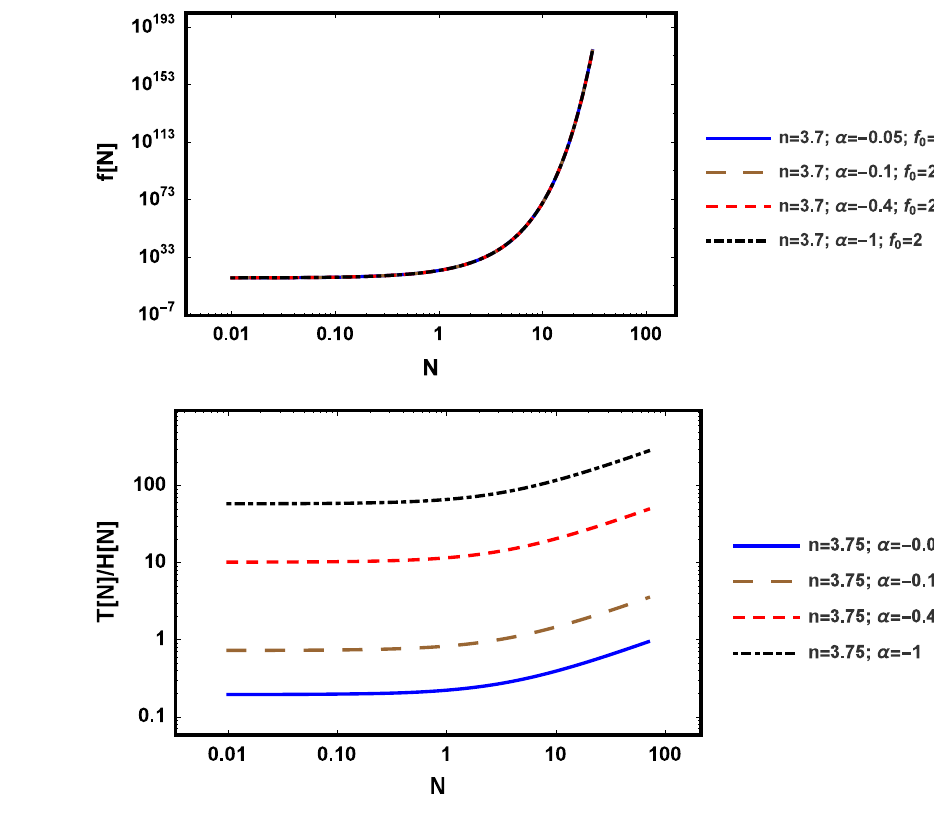
By using the value of the scalar field at horizon crossing,